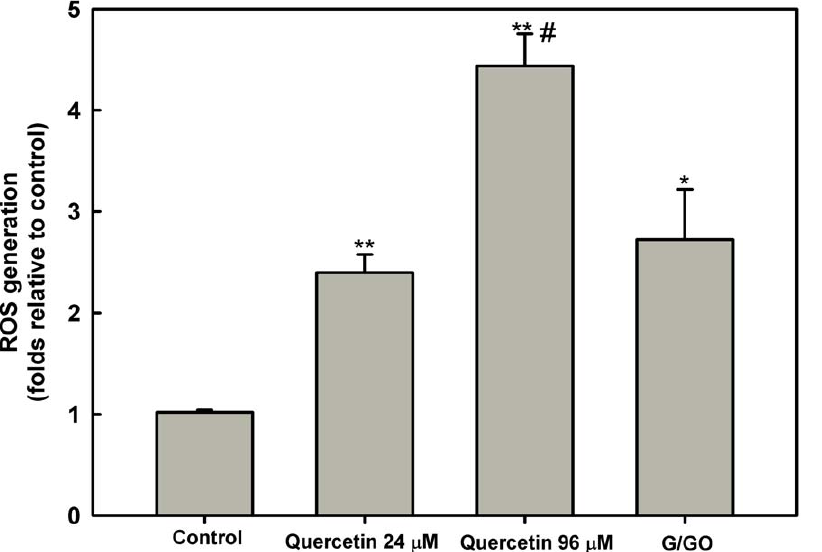
Figure 5. Quercetin induced ROS formation. Leishmania amazonensis was cultivated in Schneider’s Drosophila medium at 26 u C as for 48 h in the absence or presence of 24 m M or 96 m M quercetin. Generation of ROS was measured using fluorescent dye H 2 DCFDA as described under Materials and Methods. Data are expressed as fold increase in ROS production relative to control. Values shown are the mean 6 standard error of three different experiments. Positive control was obtained by addition of 20 units/ml glucose oxidase + 60 mM glucose for 20 minutes. * indicates significant difference relative to the control group ( p , 0.05); ** indicates significant difference relative to the control group ( p , 0.01); # indicates significant difference relative to the 24 m M quercetin treated group ( p , 0.05). G/GO 2 Glucose + Glucose oxidase.